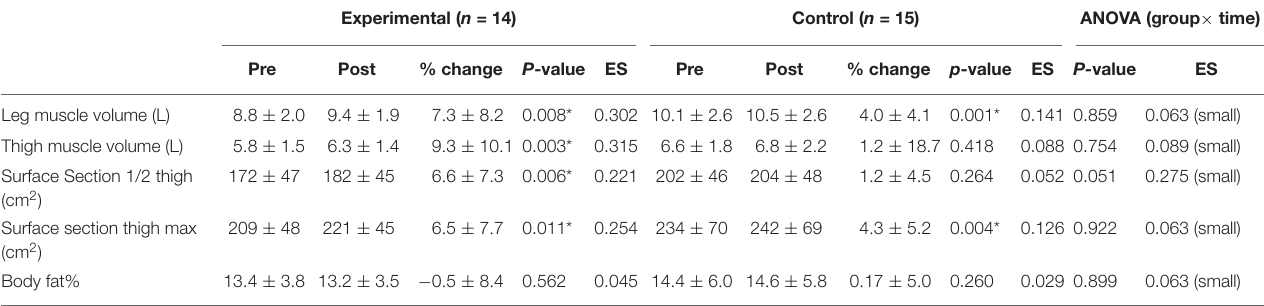
TABLE 4 | Comparison of muscle volume of lower limbs and% body fat between experimental and control groups before and after the 8 weeks intervention. Experimental ( n = 14) Control ( n = 15) ANOVA (group ×